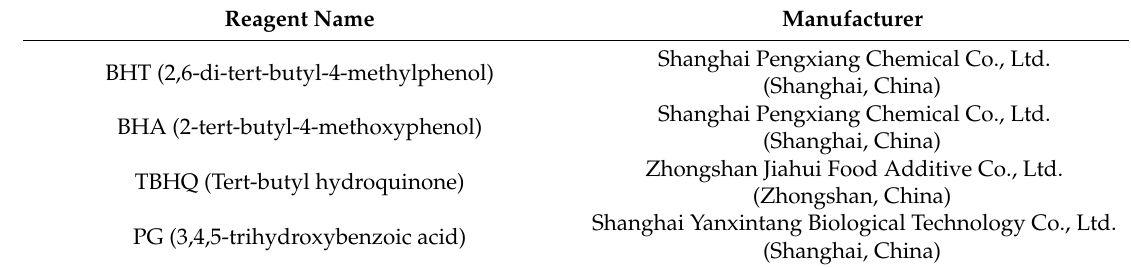
Table 1. Main reagents used in the